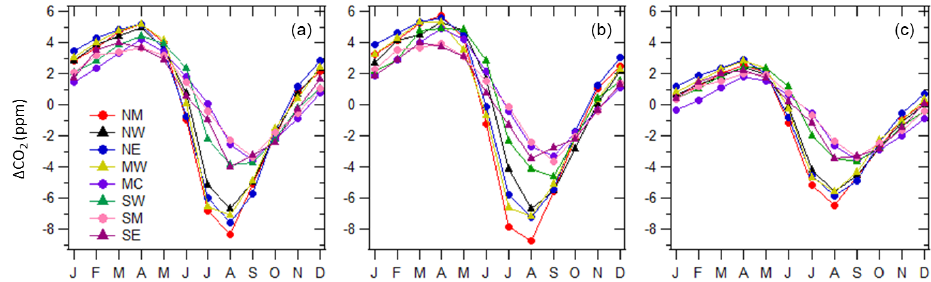
Figure 7. (a) Partial column (cid:49) XCO 2 calculated from aircraft and tower data; (b) partial column (cid:49) XCO 2 calculated from CT2015; (c) total column (cid:49) XCO 2 calculated from aircraft and tower data, including the top-layer data from CT2015.